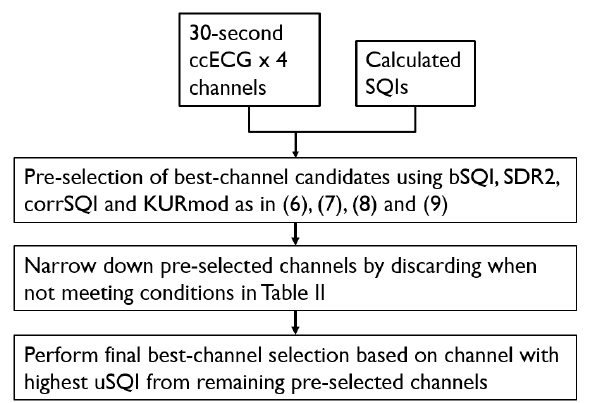
Figure 4. Block diagram of algorithm using SQIs and additional signal parameters.